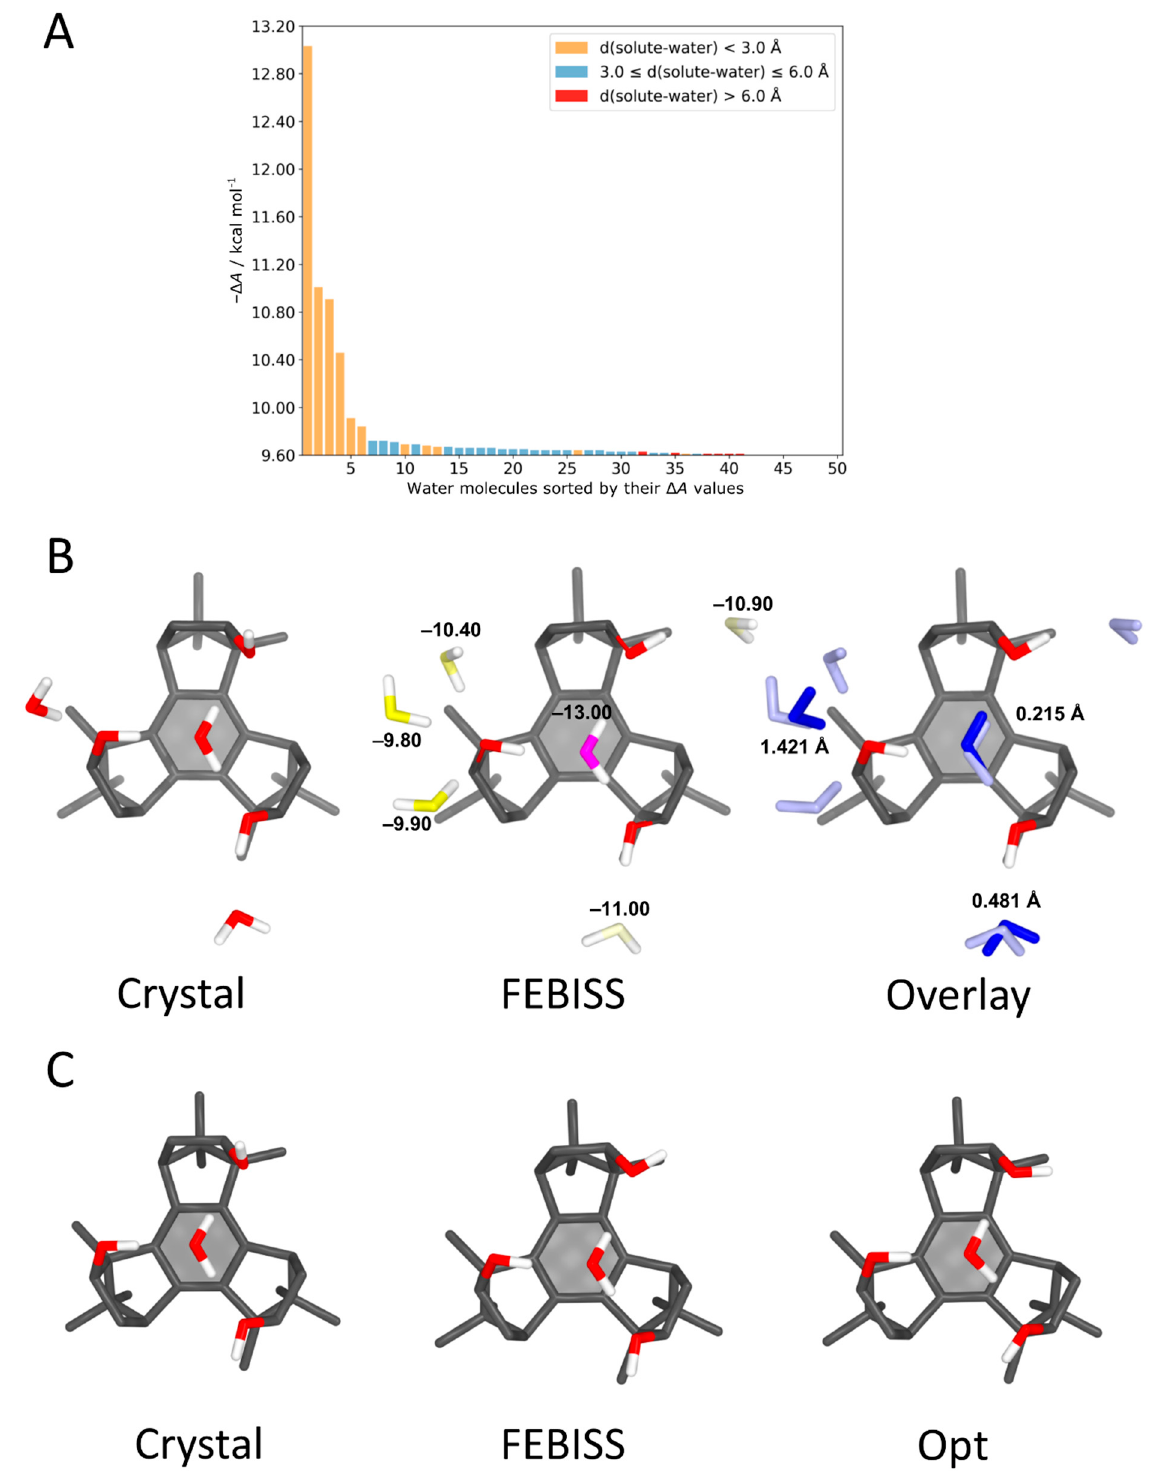
Figure 8. ( A ) Automated water placement of (+)- syn -benzotriborneol. ( B ) Comparison of the crystal structure with crystal waters (left) and our FEBISS water positions (middle) as well as an overlay of the two (right). FEBISS water positions are depicted in light blue, and crystal waters in dark blue; the depicted values indicate free energies of solvation (middle) and root mean square deviation between the crystal and the nearest FEBISS water (right). ( C ) Comparison of the crystal structure with one explicit water (left), the FEBISS water position (middle) and the B3LYP/def2-TZVP/D3 optimized (+)- syn -benzotriborneol-(H 2 O) cluster structure (right).